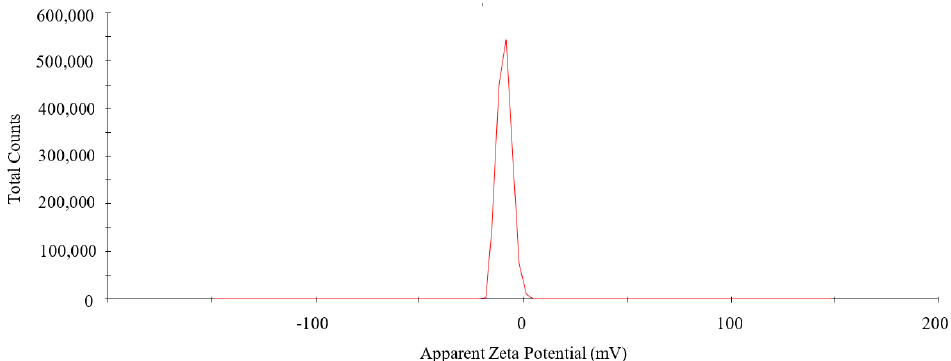
Figure 4. Zeta potential of PtNPs.